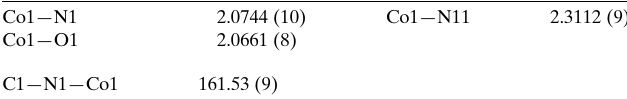
Table 1 Selected geometric parameters (A˚ , (cid:4) ).